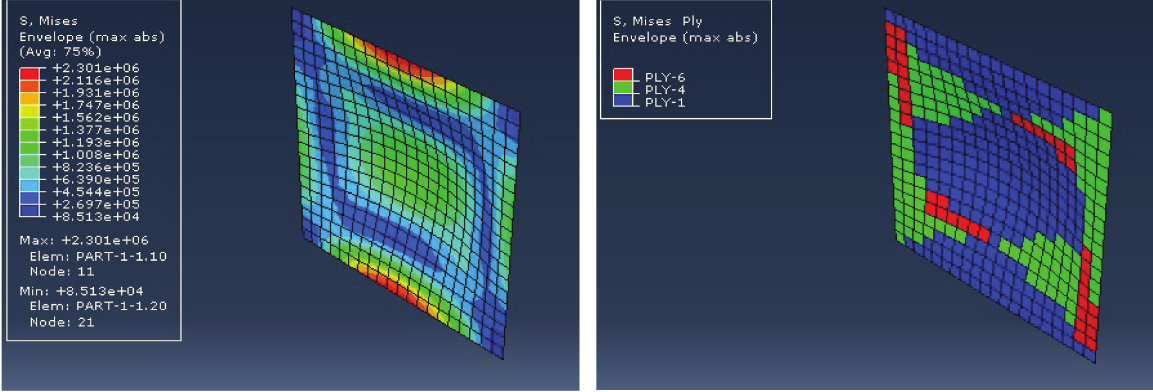
Figure 10 Maximum stress and subjected plies for SGA solution.